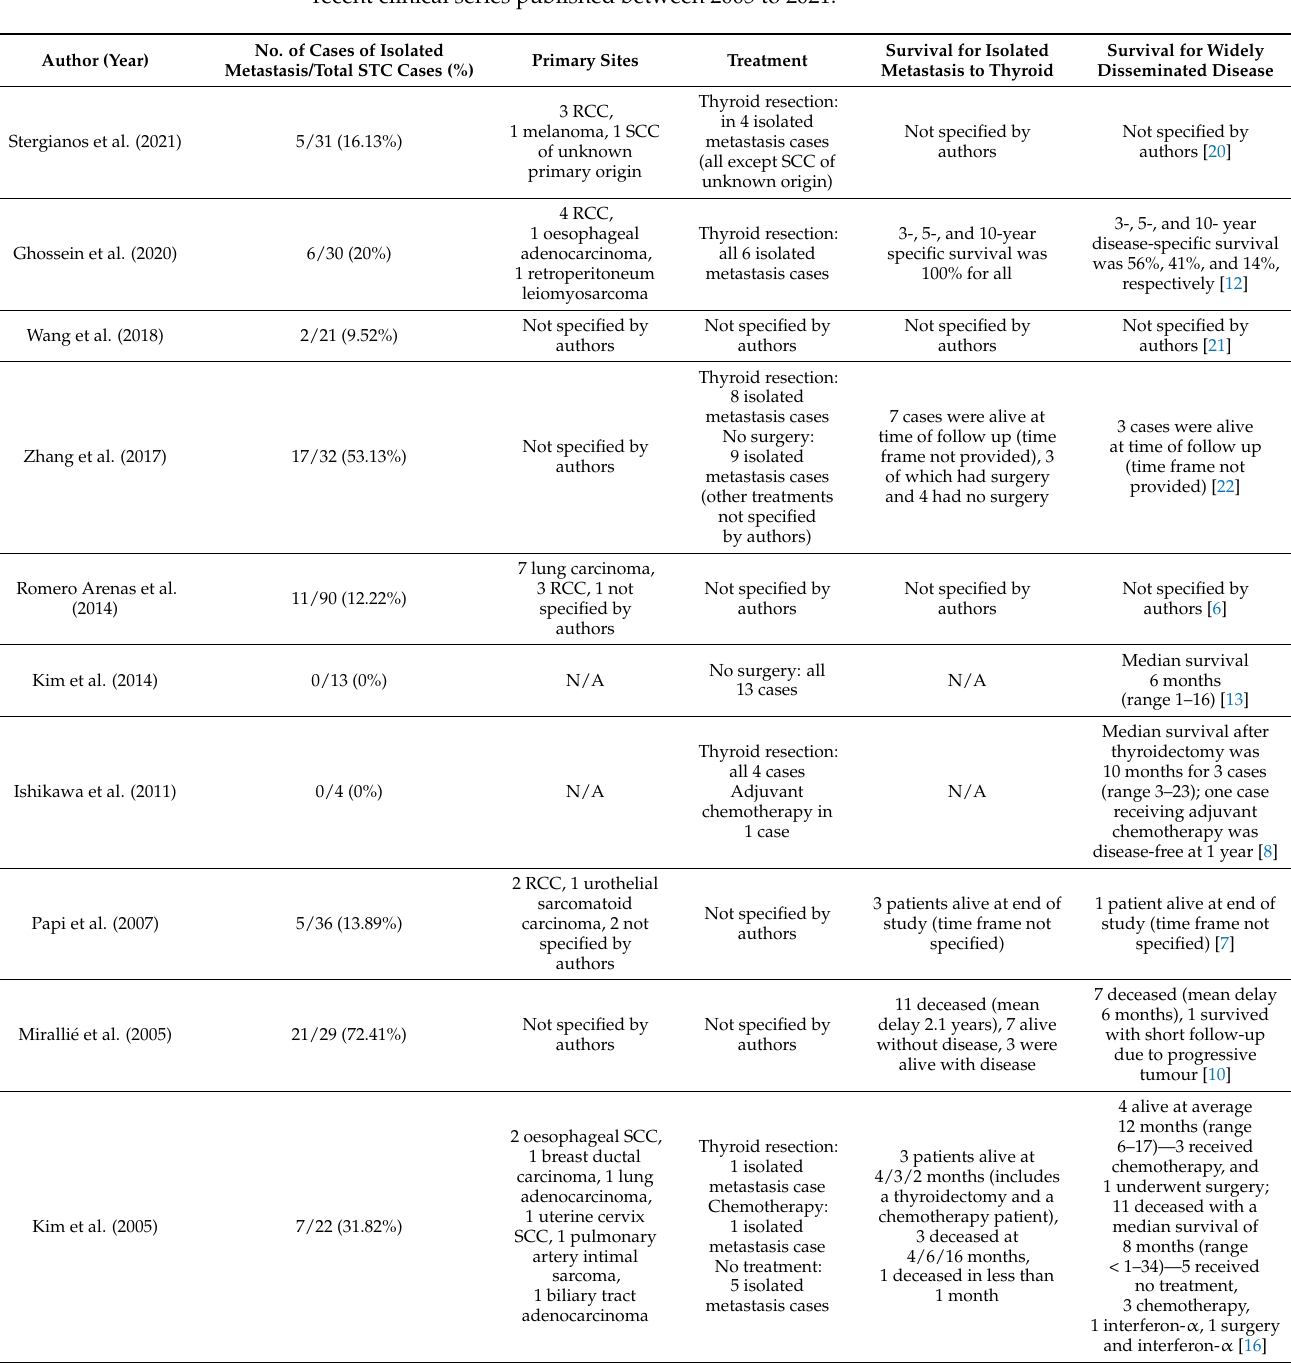
Table 1. Characteristics of patients with sole/isolated metastasis to the thyroid gland, as described in recent clinical series published between 2005 to